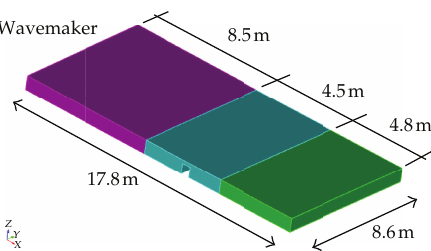
Figure 2: Bodies to define mesh geometry for the impervious structure